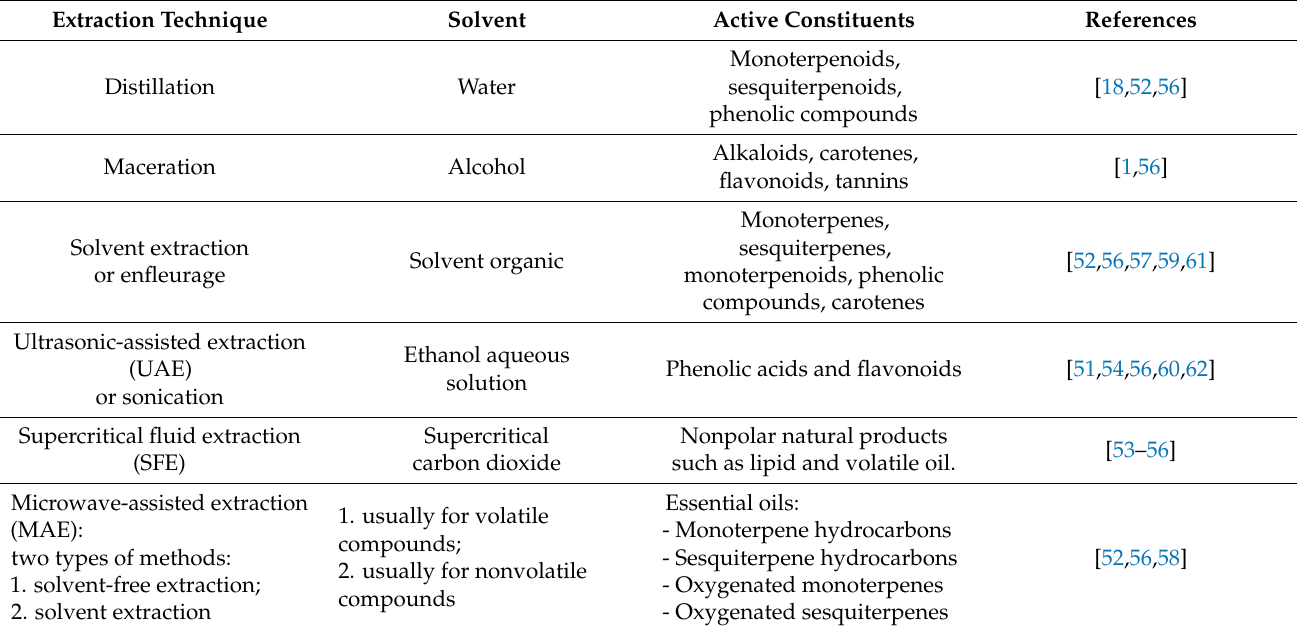
Table 1. Methods for obtaining bioactive compounds from Helichrysum arenarium (L.)